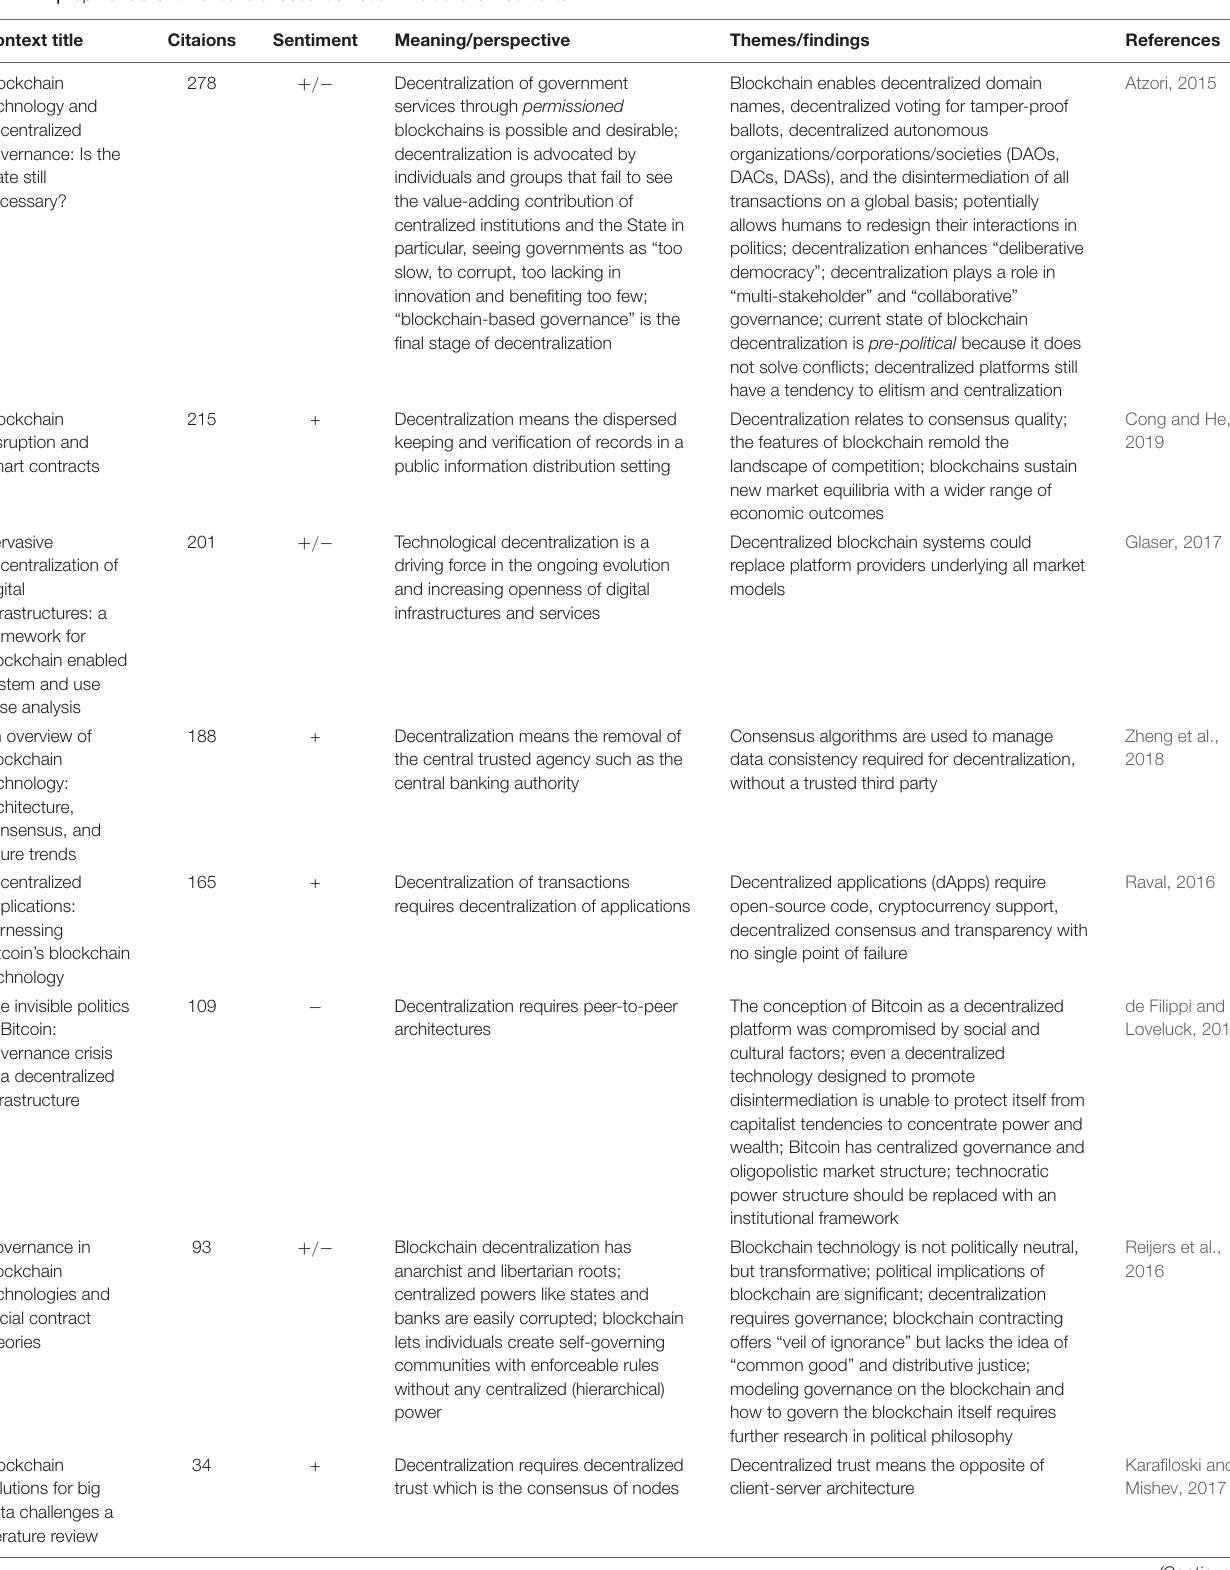
TABLE 2 | Top 16 relevant mentions of decentralization in blockchain